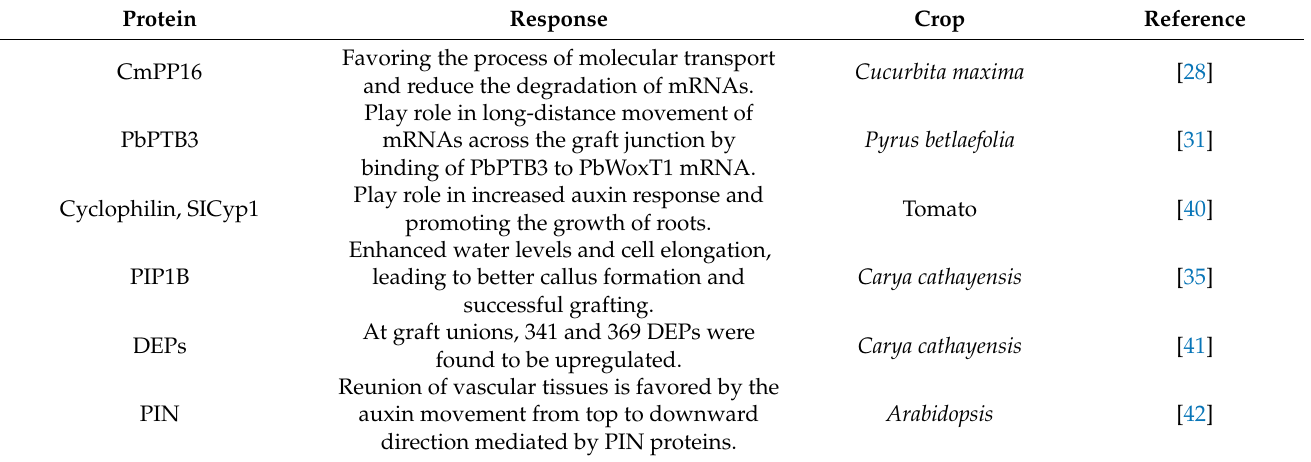
Table 1. Details of various proteins and their differential expression in horticultural